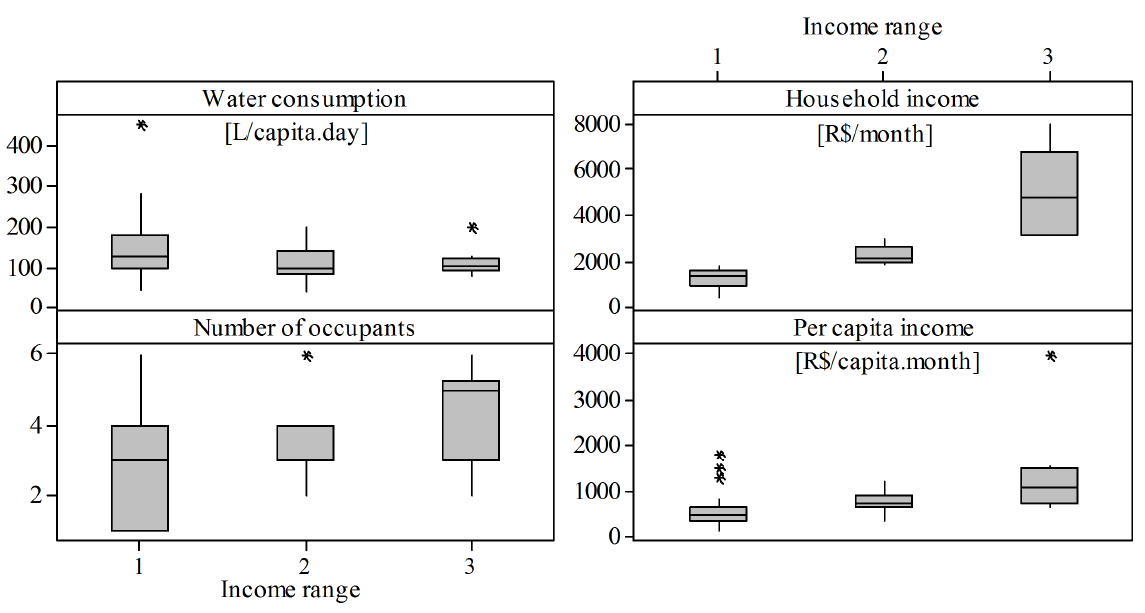
Figure 2. Socioeconomic characteristics of studied